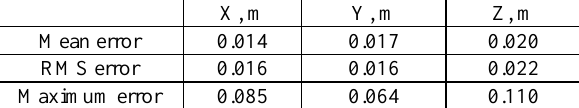
Table 6. Absolute accuracy estimation of MLS data adjustment using check points every 2 km and control points every 2 km Maximum error of vertical position was decreased in 2 times and started to be within the tolerance. This means that application of control points every 2 km is enough for scanning adjustment using check points every 2 km and control points